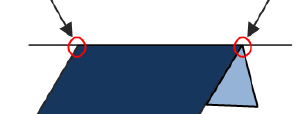
Figure 4: Intersection line of two planes